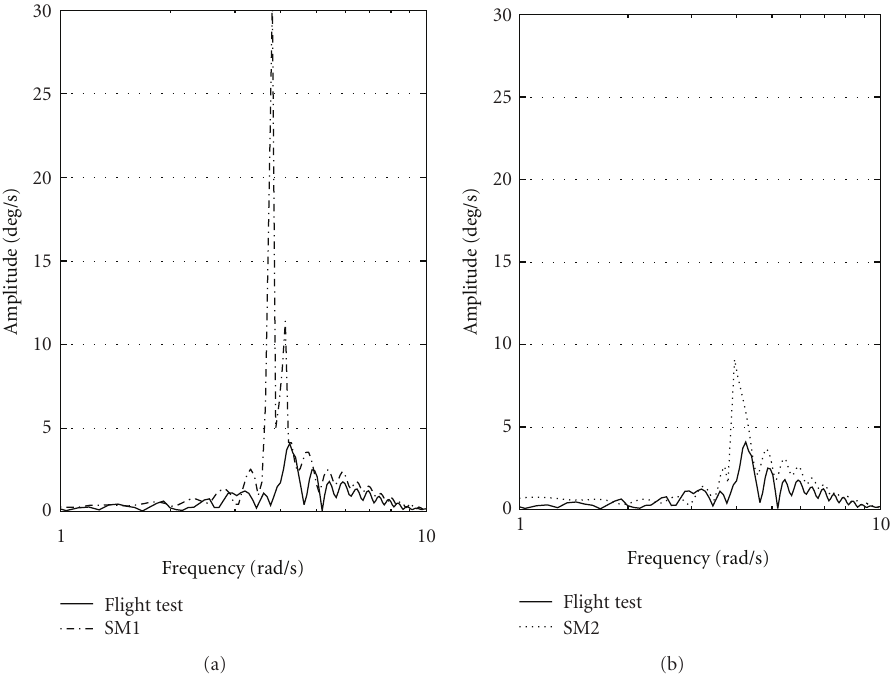
Figure 12: The e ff ect of model complexity on pitch rate spectral response (main